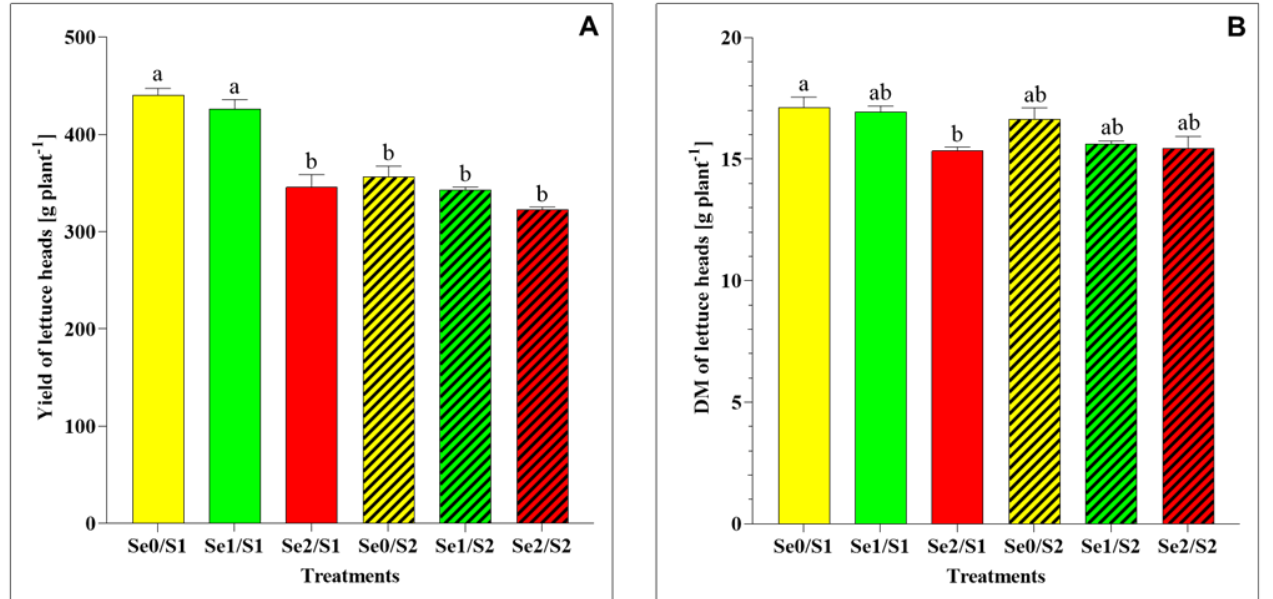
Figure 2. ( A ) Yield and ( B ) dry matter (DM) accumulation in lettuce plants grown in a hydroponic system and treated with two S levels (S1: 1 mM; and S2: 2 mM (K 2 SO 4 )), and three Se levels (Se0: 0 µM; Se1: 1.3 µM; and Se2: 3.8 µM (Na 2 SeO 4 )). The data presented are the means ± standard error of the means (SEMs) of four replicates. Different letters show statistically significant differences among all the treatments ( p ≤ 0.05; Tukey’s test).